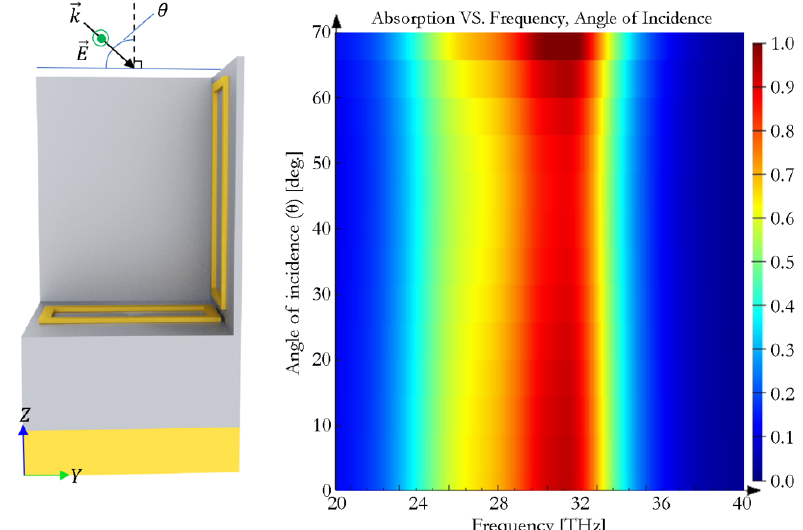
Figure 6. ( left ) The DSRR unit cell geometry is shown, also illustrating variation of the angle of incidence, θ . ( right ) Spectral absorption is plotted as a function of frequency and angle of